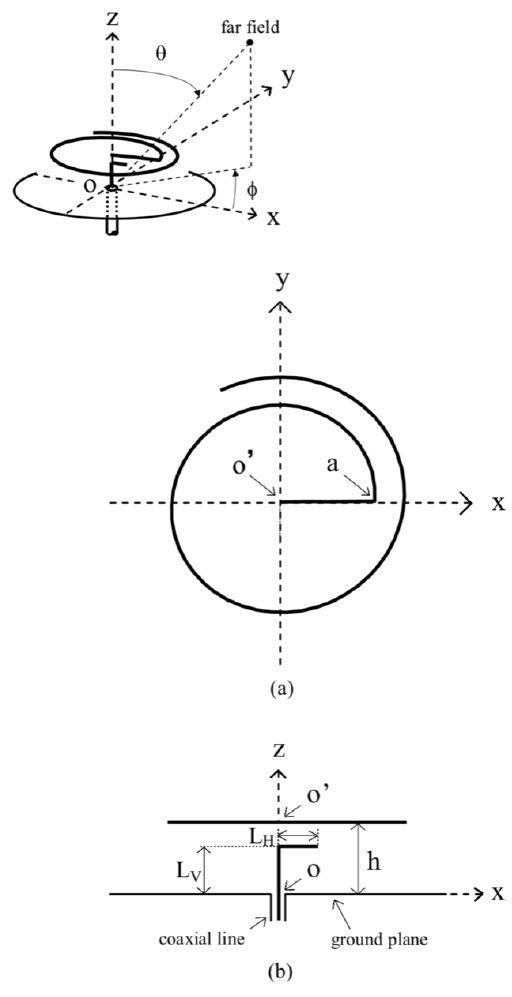
Figure 6. Curl antenna with an electromagnetic coupling feed: ( a ) perspective and top views; ( b ) side view.